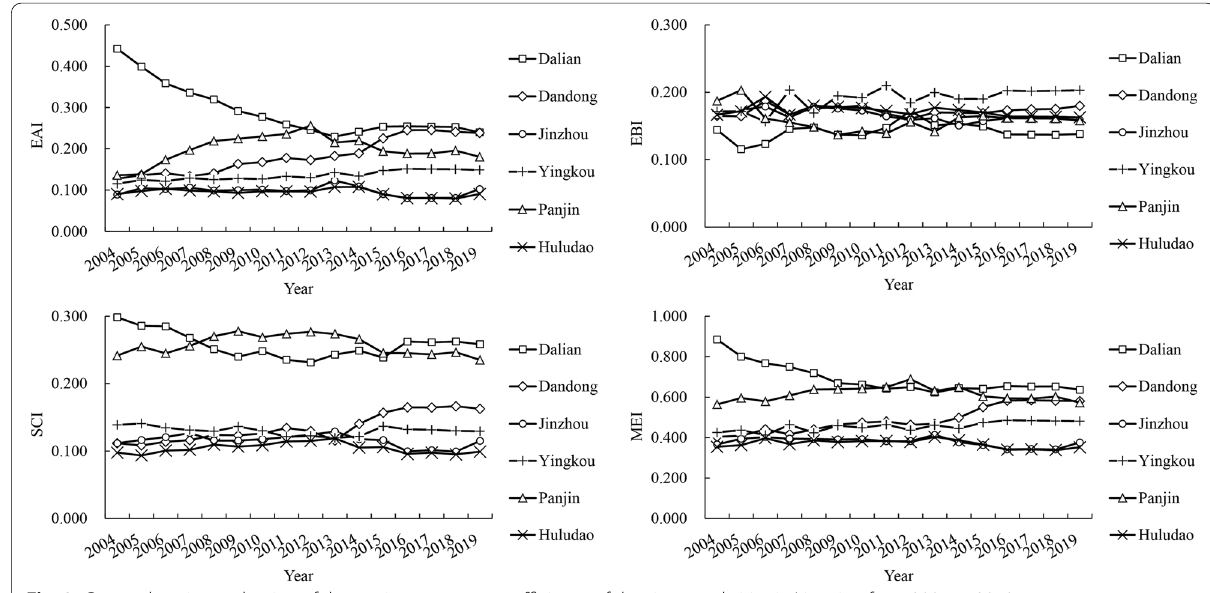
Fig. 3 Comprehensive evaluation of the marine governance efficiency of the six coastal cities in Liaoning from 2004 to